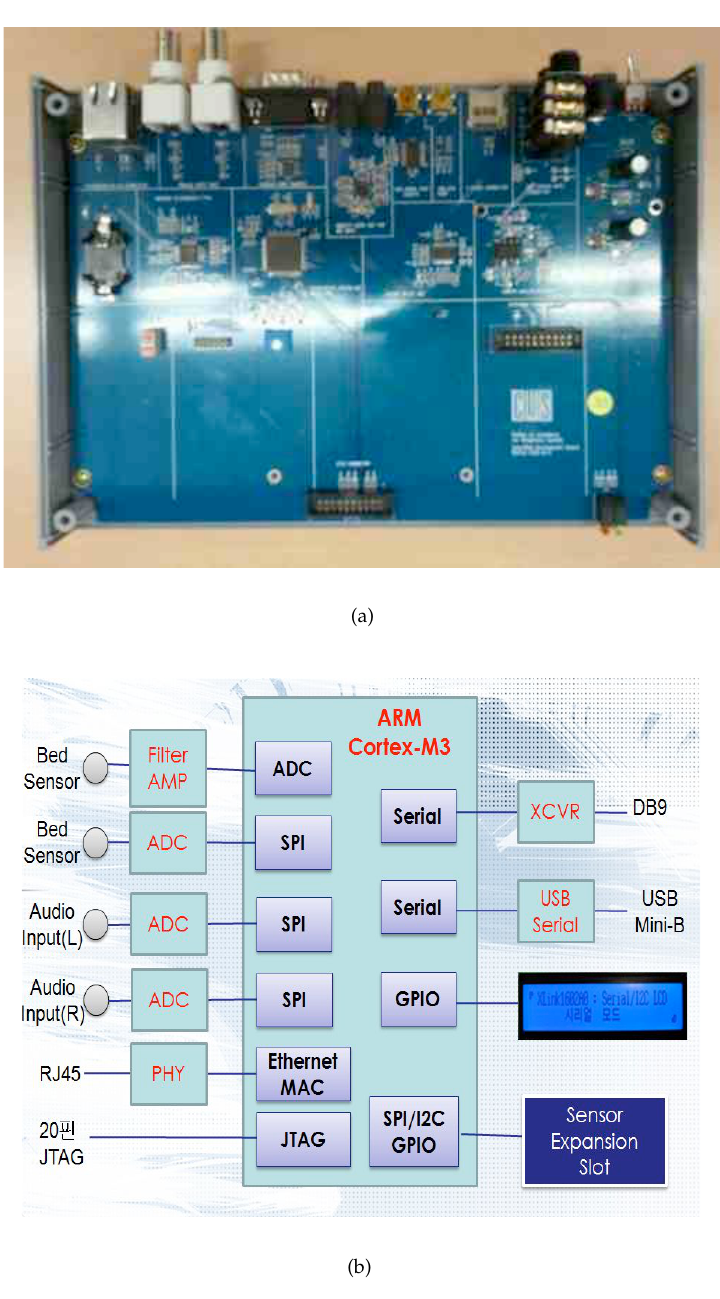
Figure 6. Analog-to-digital converter (ADC) board. ( a ) ADC board; ( b ) architecture of ADC board.